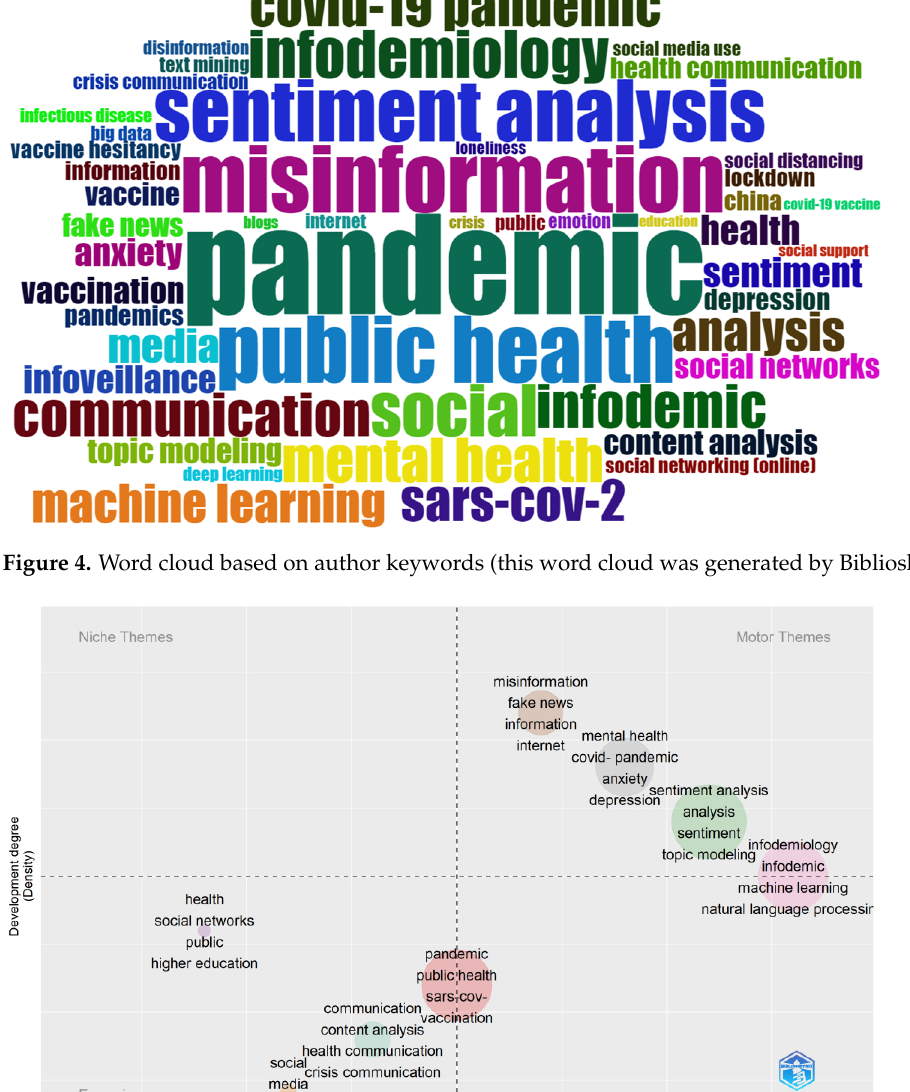
Figure 4. Word cloud based on author keywords (this word cloud was generated by Biblioshiny).